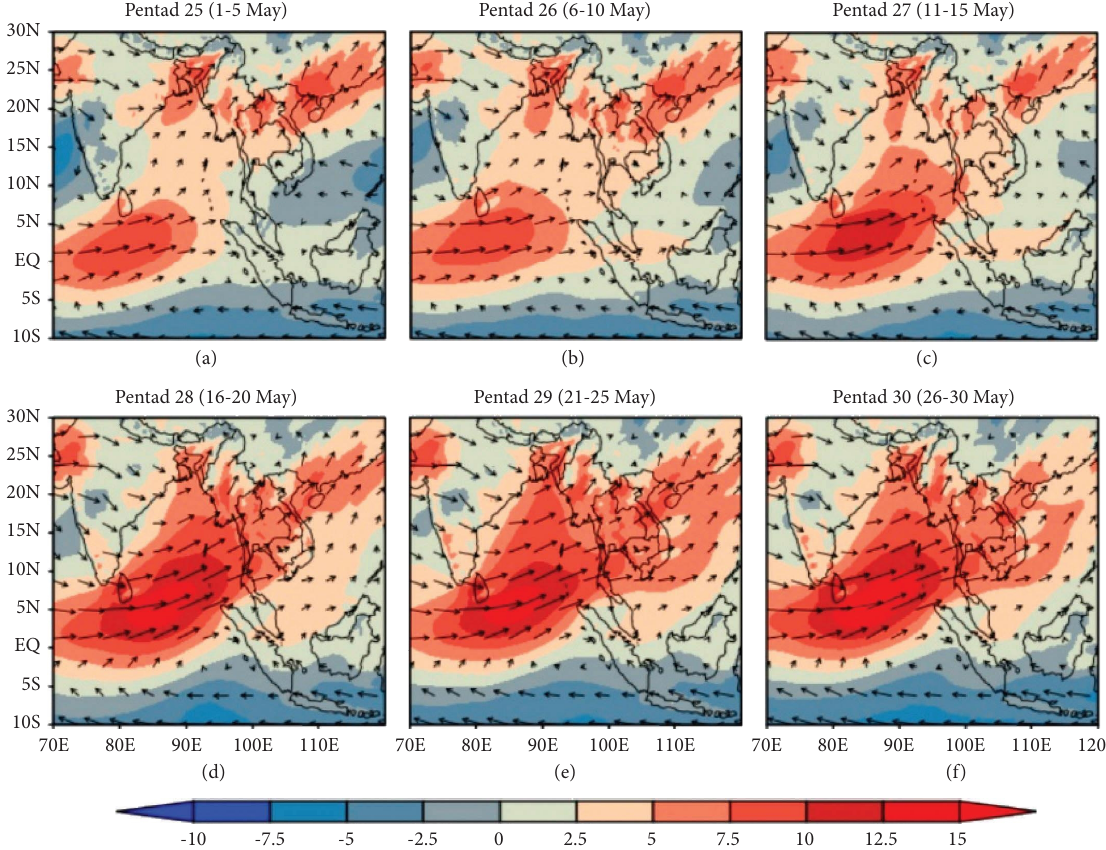
Figure 13: Composite of climatology (1991–2020) wind component strength (ms − 1 , colour) and wind direction (vector arrow) at 850hPa level during the pentads (a) P -25 (May 1–5), (b) P -26 (May 6–10), (c) P -27 (May 11–15), (d) P -28 (May 16–20), (e) P -29 (May 21–25), and (f) P -30 (May 26–30) during monsoon onset